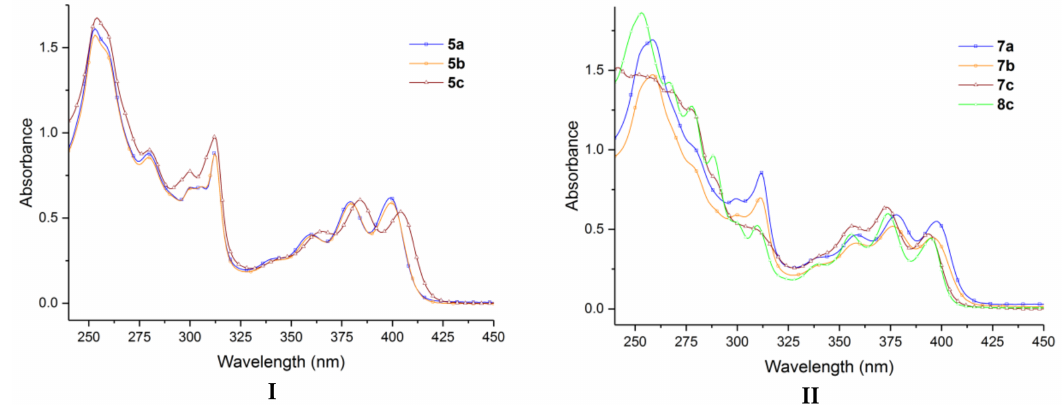
Figure 2. The absorption spectra recorded in cyclohexane solution of the azasteroid derivatives: ( I )- 5a – c ; ( II )- 7a – c and 8c